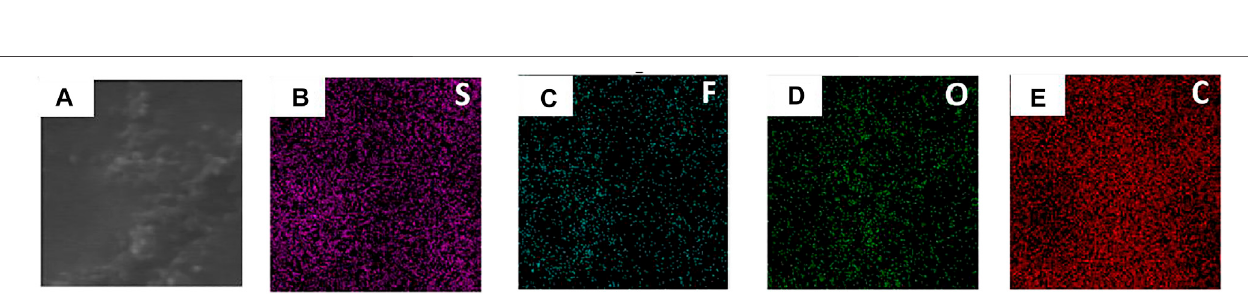
Frontiers in Chemistry |